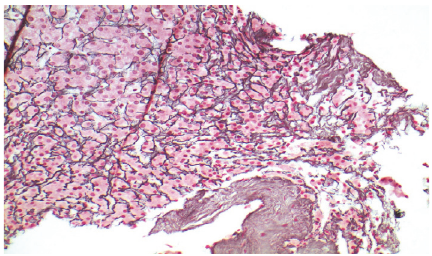
Figure 4: (Reticulin, 200x) hepatic plate thinning and compression adjacent to an area of